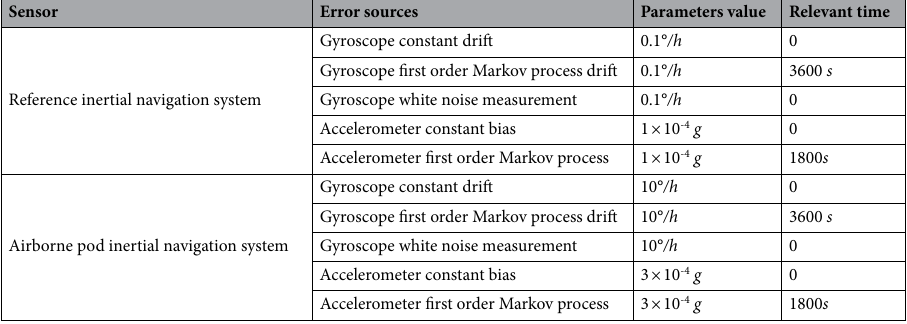
Table 1. Parameters of navigation